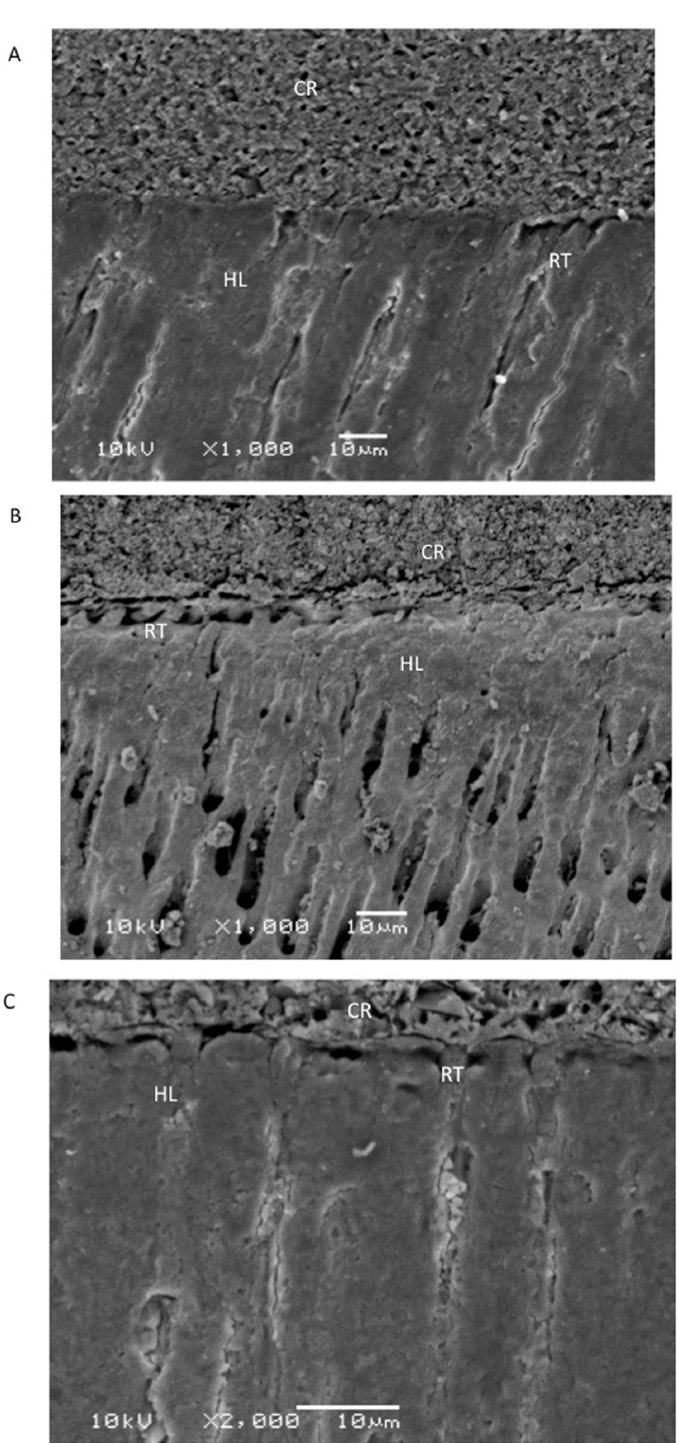
Figure 4. High-magnification images of resin–dentin interface showing: ( A ) composite resin (CR),